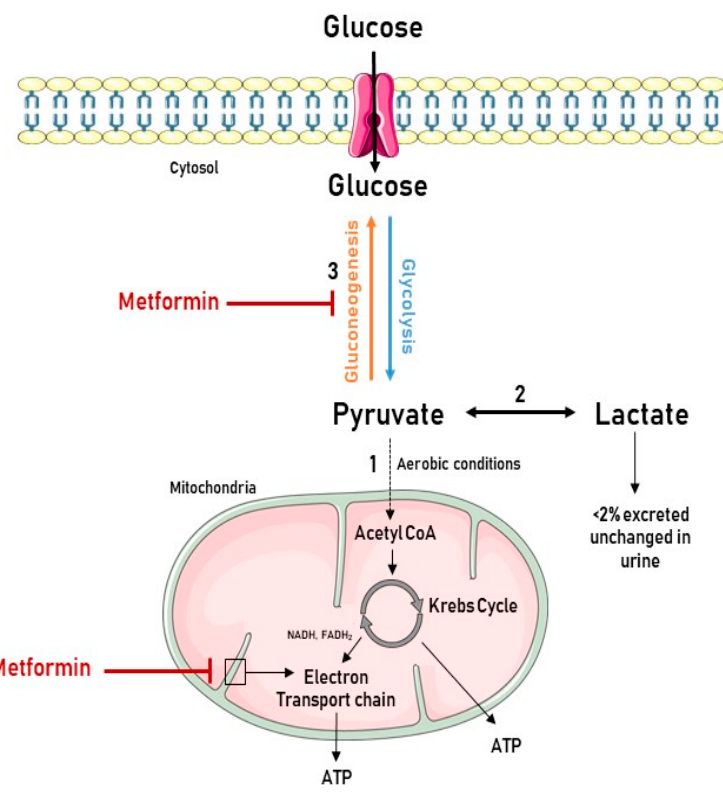
Figure 2. Association between the biochemistry of lactate production and metformin use. Glycolysis is the metabolic pathway that converts glucose into pyruvate in the cytoplasm. Pyruvate is the only precursor of lactate. ( 1 ) When oxygen is available, pyruvate enters the mitochondria, and is converted to Acetyl CoA and oxidized in the Krebs cycle, delivering nicotinamide adenine dinucleotide (NADH), flavin adenine dinucleotide (FADH2), and adenosine triphosphate (ATP). NADH and FADH2 feed the electron transport chain in the inner mitochondrial membrane to eventually generate the bulk of ATP by chemiosmosis. ( 2 ) Under anaerobic conditions, pyruvate is reduced to lactate. However, in the liver and kidney, lactate can be converted to pyruvate again by the Cori cycle. ( 3 ) Pyruvate, the first designated substrate of the gluconeogenic pathway, can be used to generate glucose. Metformin inhibits gluconeogenesis, leading to pyruvate accumulation and subsequent increased lactate production. It also inhibits the electron transport chain, resulting in elevated levels of NADH, a reduced Krebs cycle flow and, hence, further contributing to increased pyruvate levels. Figure was produced using Servier Medical Art: https://smart.servier.com/ (accessed on 25 October 2018).